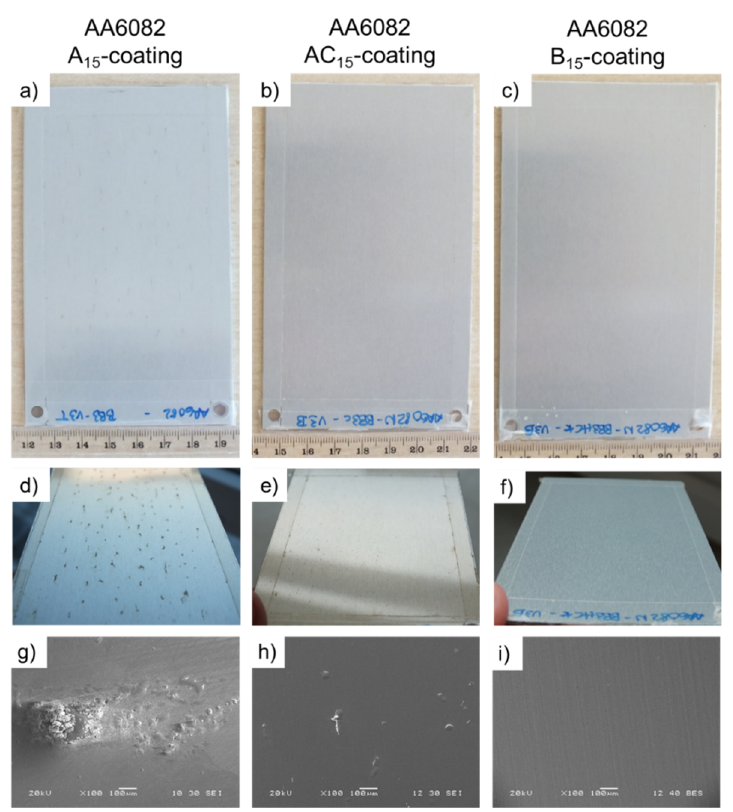
Figure 8. Straight and tilted photographs and SEM images of AA6082 T6 coated with Sol A ( a , d , g ), Sol B ( b , e , h ) and Sol AC ( c , f , i ) at 15 cm/min after 168 h of exposure in NSST.